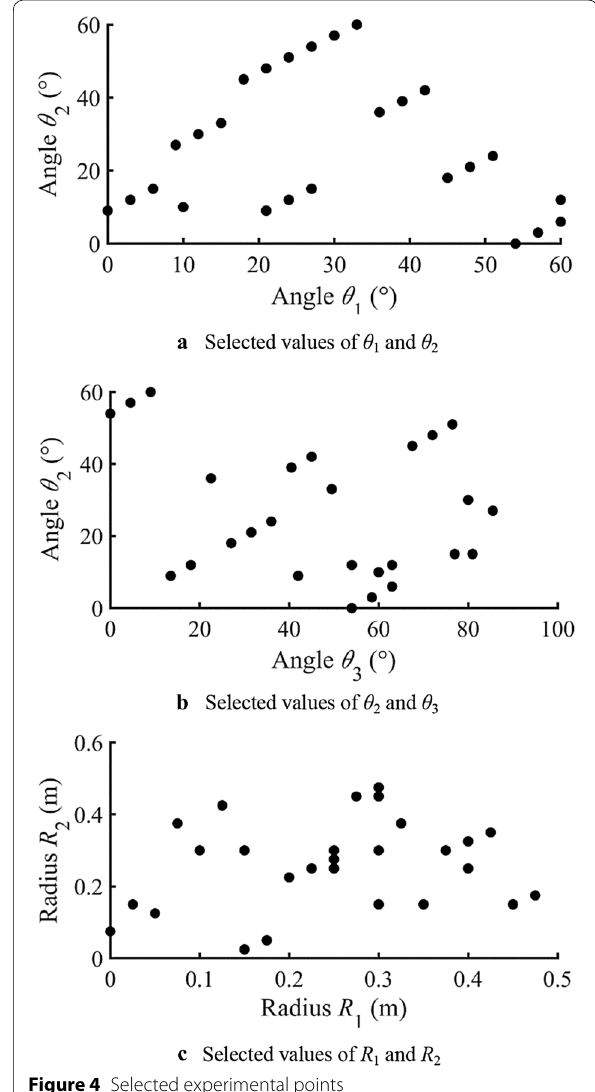
Figure 4 Selected experimental